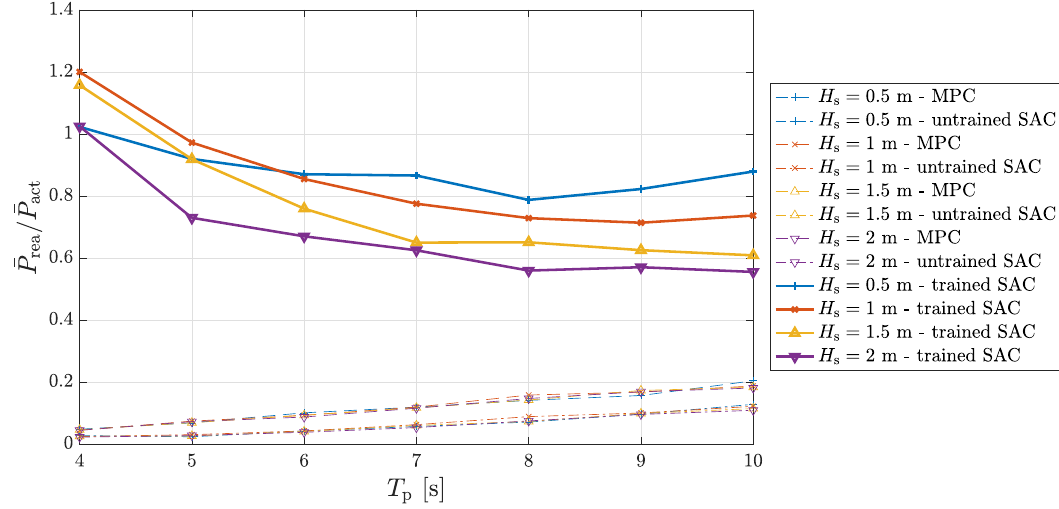
Figure 6. Variation with peak wave period of the ratio of the mean reactive and active power absorbed by the heaving sphere for the considered range of significant wave